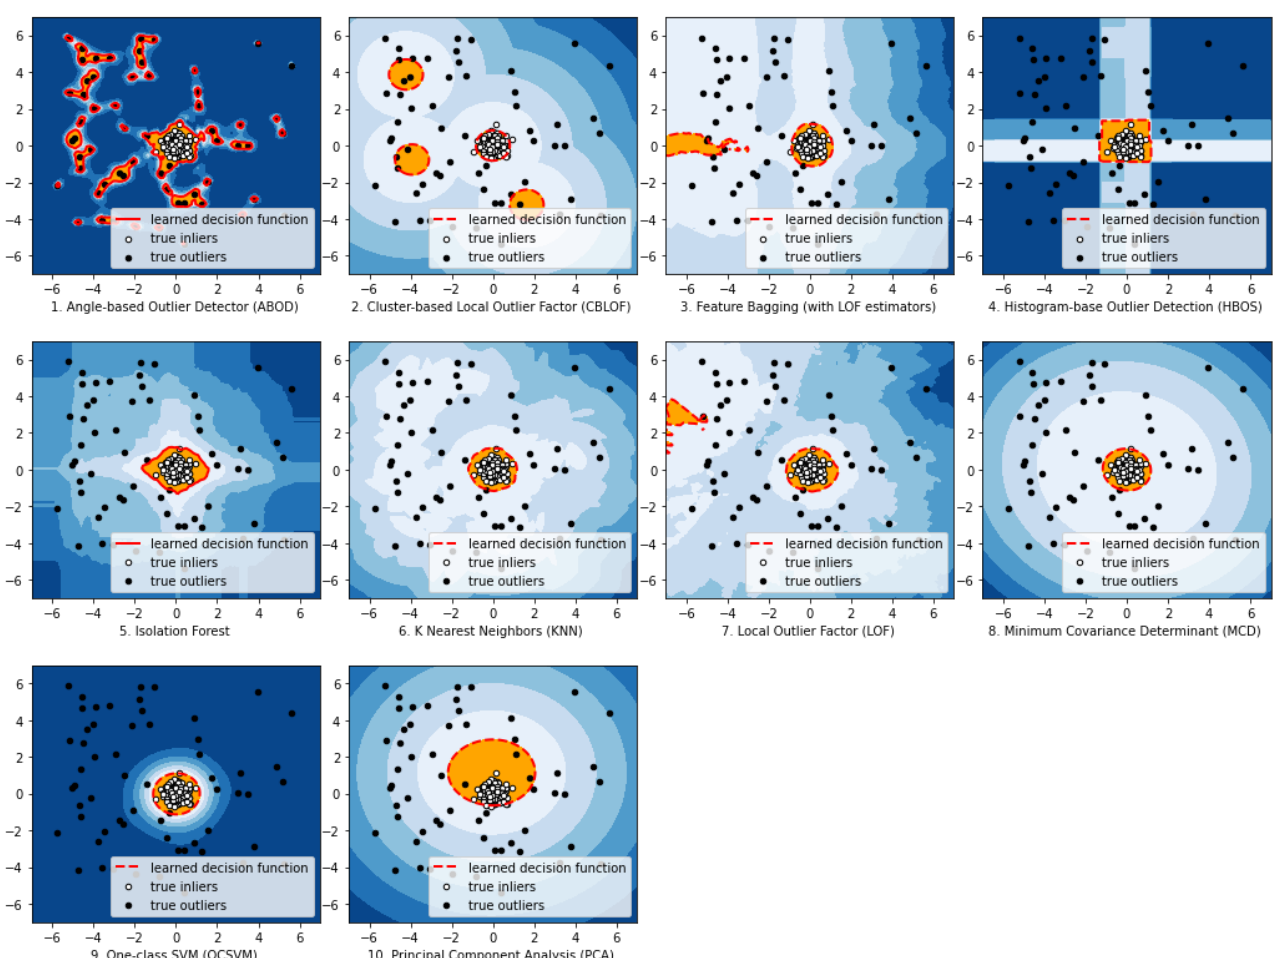
Figure 1. Decision boundaries learnt by different outlier detection methods using the same